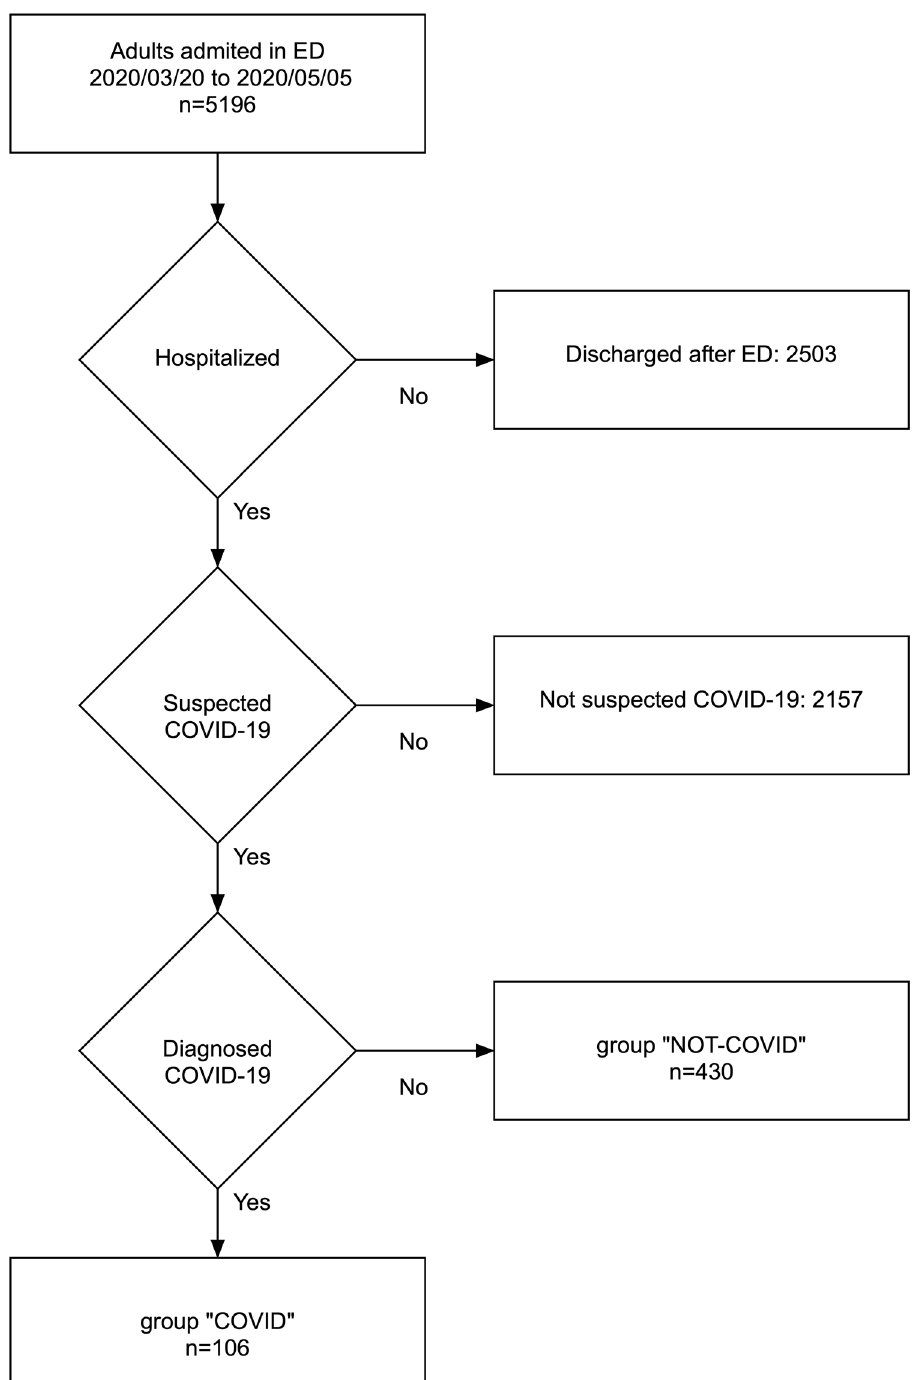
Figure 2. Flow chart of patient selection. Patients suspected to have COVID-19 had at least one of the following symptoms: cough, dyspnea, hyperthermia, myalgias, asthenia, diarrhea, confusion or anosmia. Both chest-CT and RT-PCR were performed in all patients with suspected COVID-19 who were